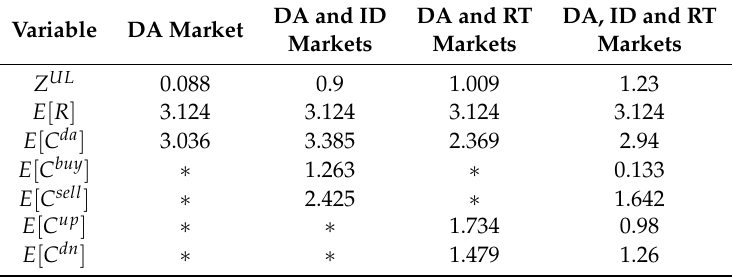
Table 4. The change of expected profit/cost of the EV aggregator under the four observed cases: n = 2 e